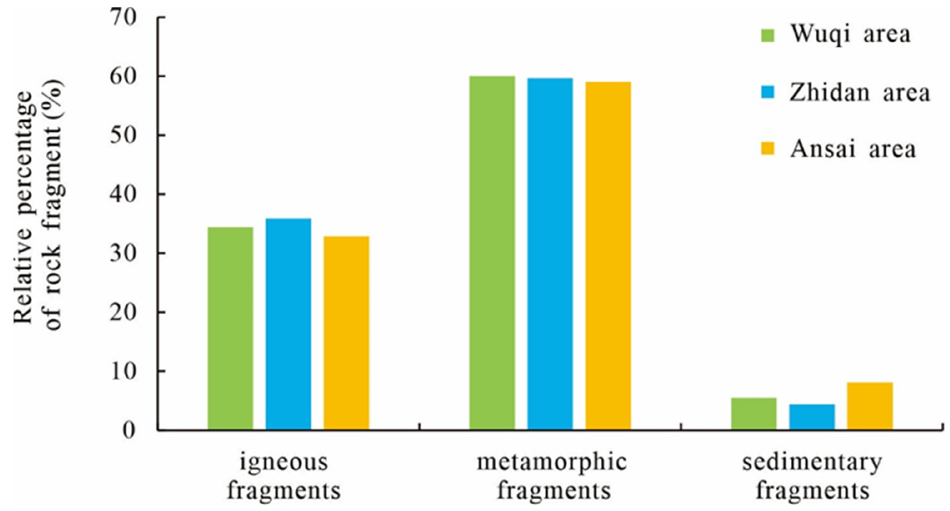
Figure 3. Relative percentage of different rock fragment types of Chang 8 Member of the Yanchang Formation tight sandstone reservoirs in study area.